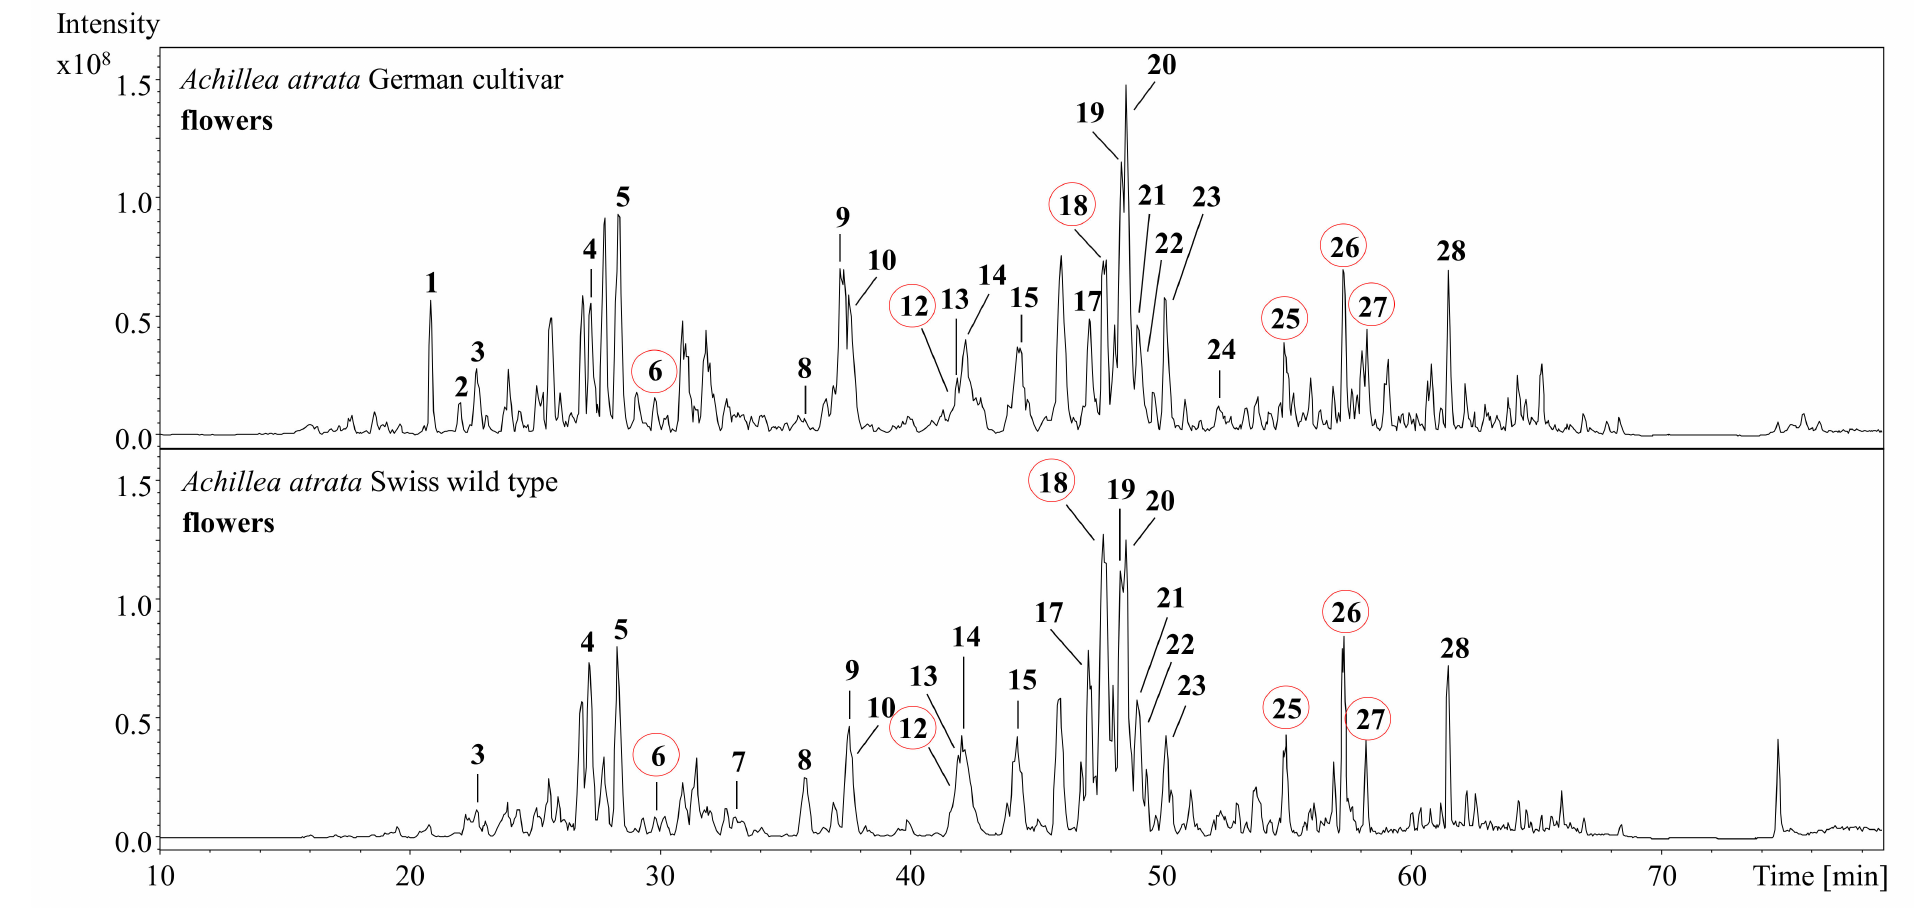
Figure 2. Comparison of total ion chromatograms of flower extracts from A. atrata variants cultivated in Germany and from the wild type grown in Switzerland. 1 : Dimethyl- O